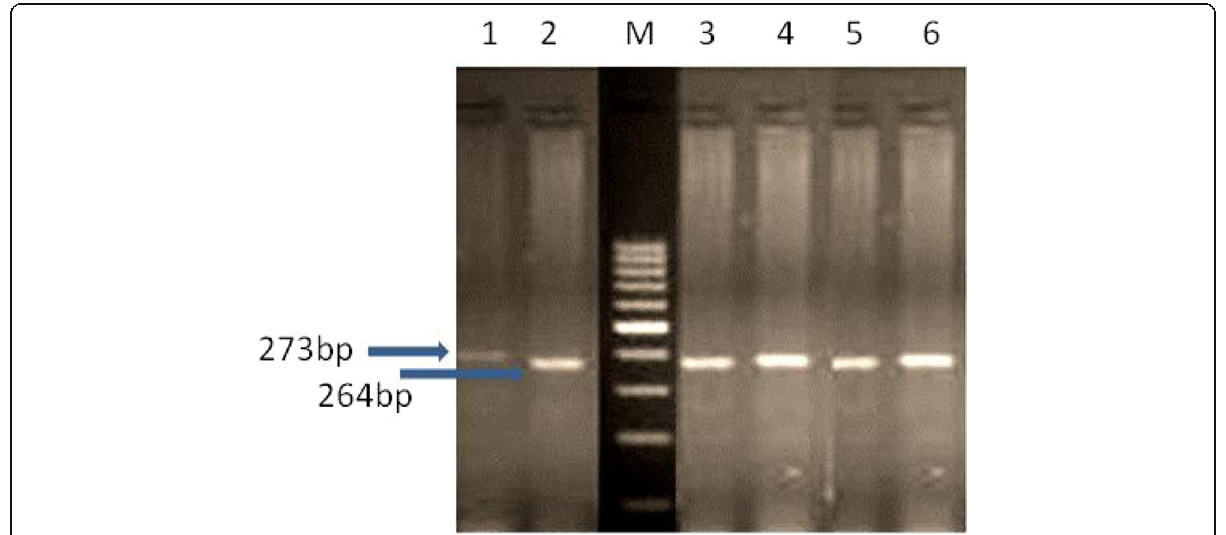
Fig. 1 Agarose gel electrophoresis of hepcidin1(264 bp) and hepcidin 2 (273 bp)-PCR fragment. M, 100 bp DNA ladder, Lanes 1, 4, and 6 (hepcidin 2). Lanes 2, 3, and 5 (hepcidin1)